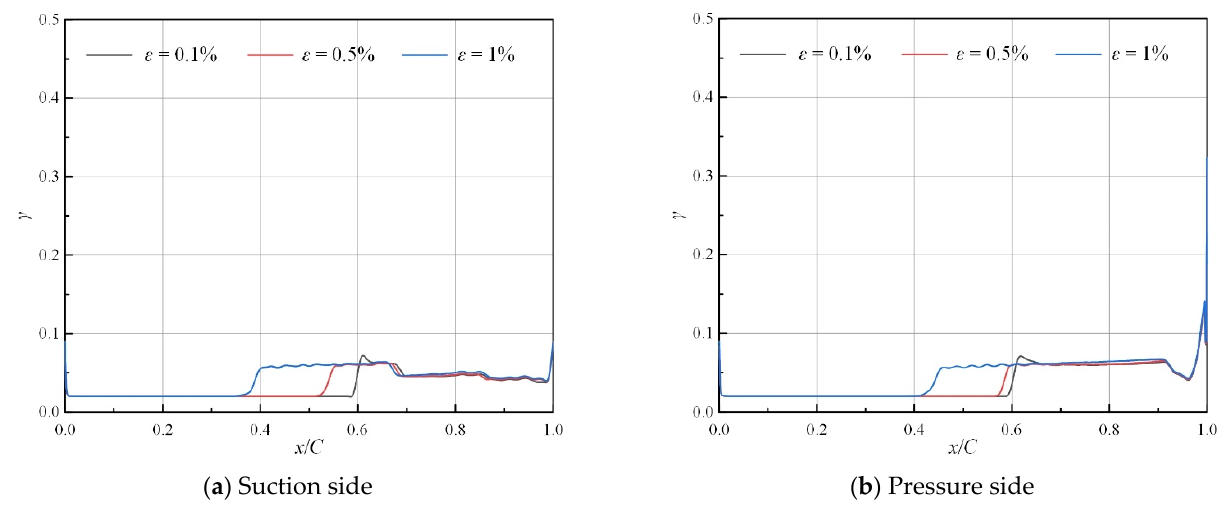
Figure 7. Distribution of intermittency along streamwise direction under various levels of turbulent intensity ( T w = 293K, α = 0°, Ma = 0.4).